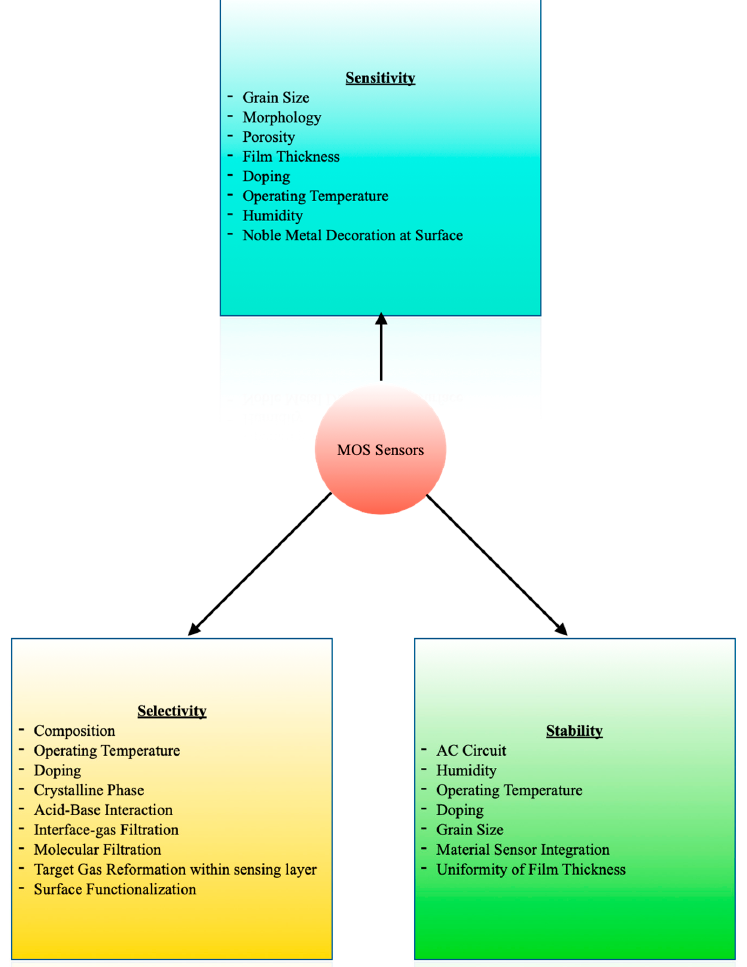
Figure 6. Parameters Affecting the Sensing Performance of MOS Sensors.